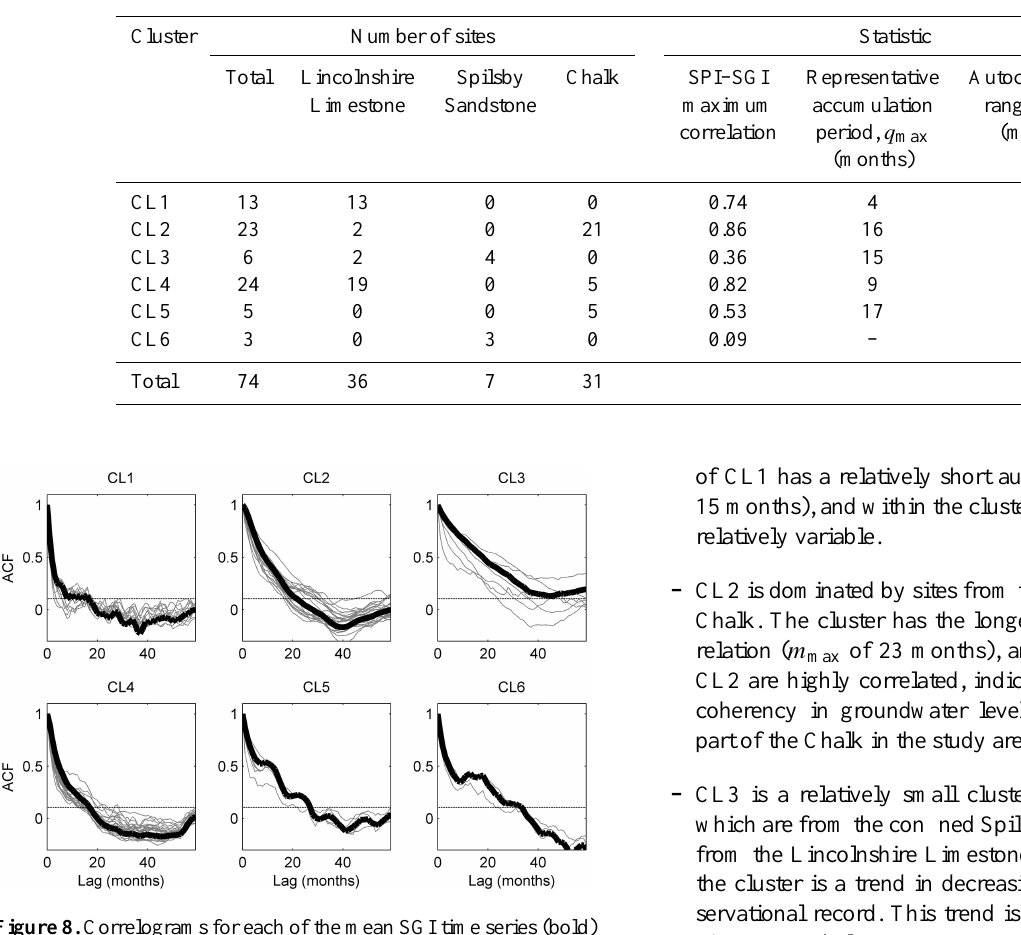
Table 1. Summary of features of the six k -means clusters.